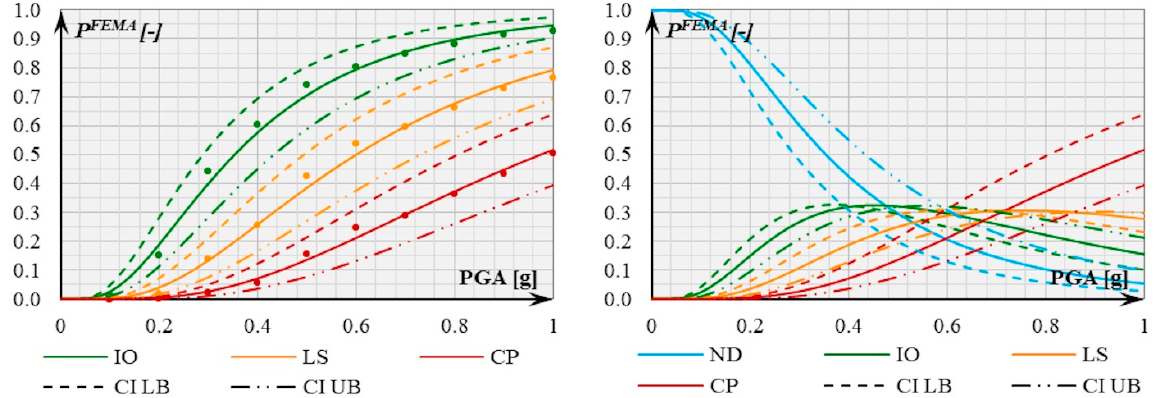
Figure 21. Fragility curves and probability density functions for the occurrence of different states of damage, according to FEMA 356 [31].